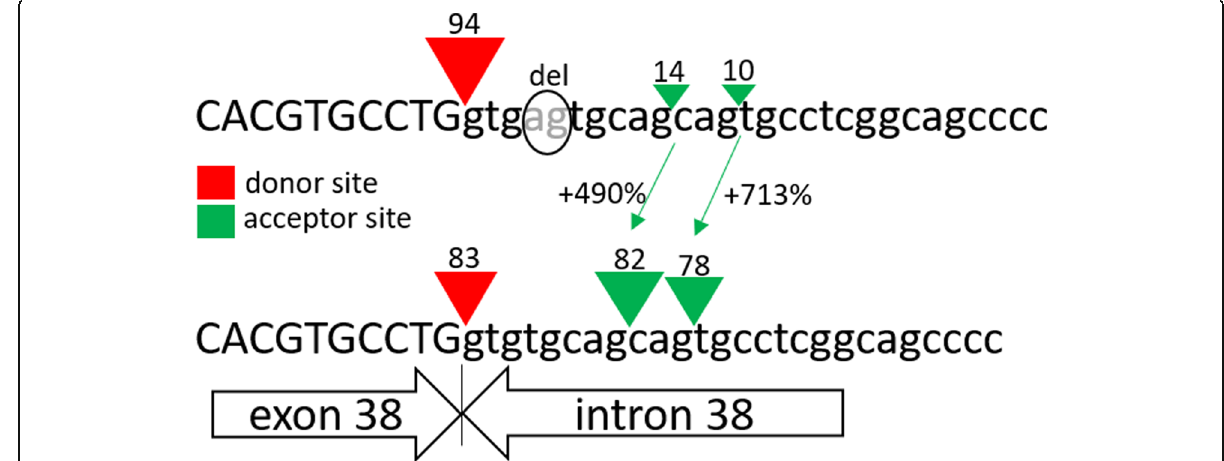
Fig. 2 Results produced by the Human Splicing Finder prediction program (HSF 3.0) for the patient ’ s intronic variant. The 2-bp deletion is strongly